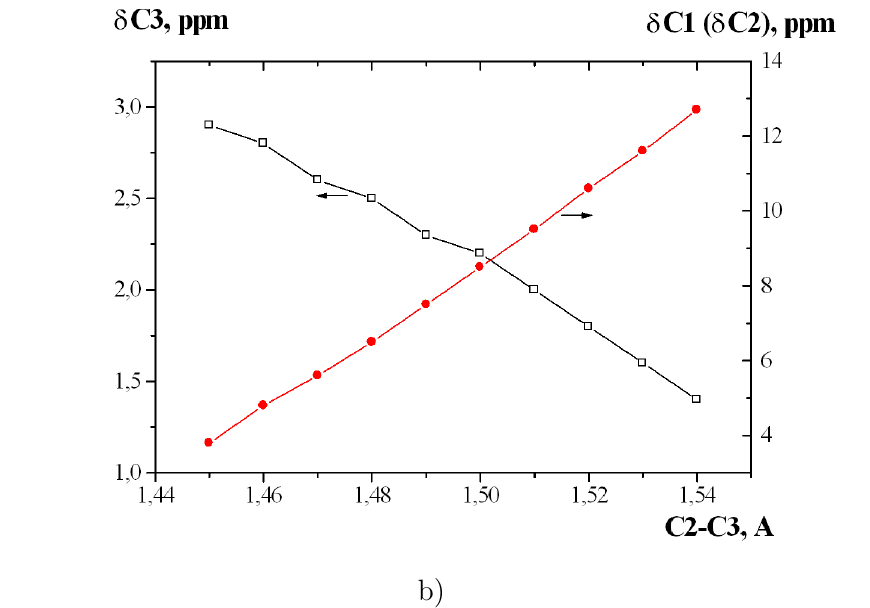
Fig. 3 Dependence of the GIAO calculated C1. C2 and C3 chemical shifts of 2 on the C1-C2 (a) and C2-C3 (b) bonds lengths. Chemical shifts calculated at B3LYP/6-311+G(2d,p) level. Constrained optimization performed at B3LYP/6-31G(d) level with Cs symmetry point group (equal C2-C3 and C1-C3 bonds